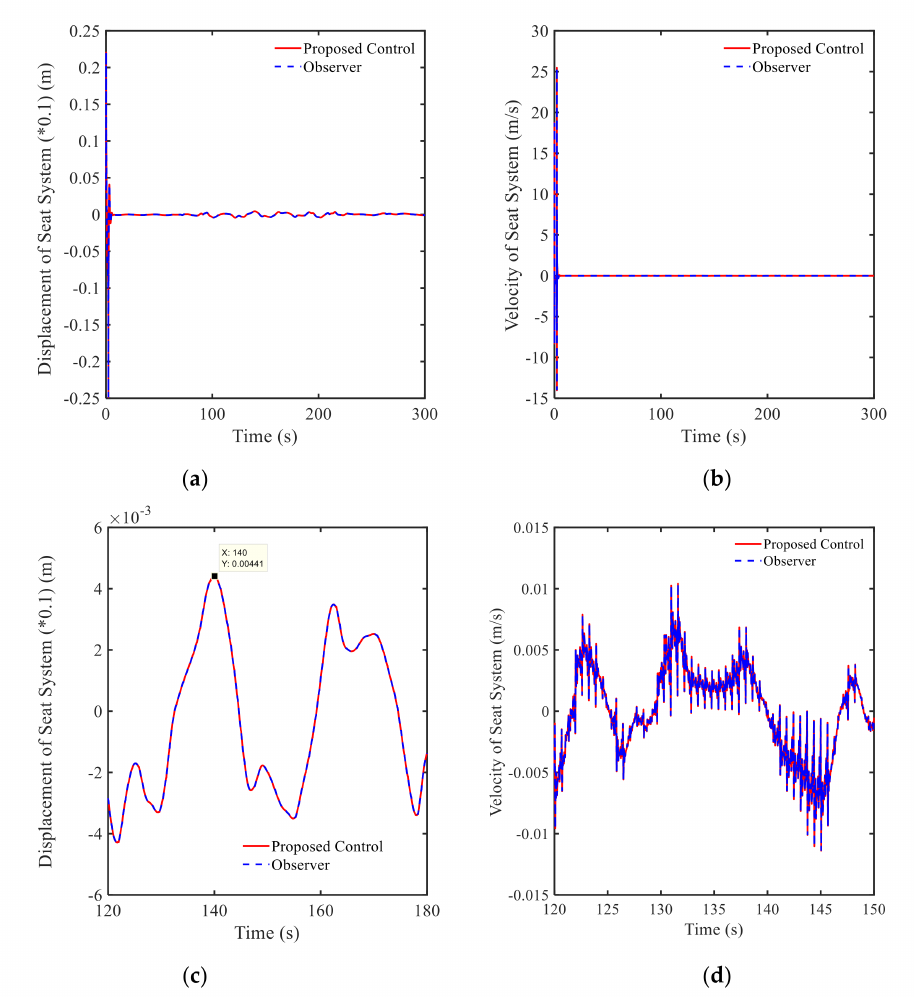
Figure 4. Displacement and velocity of the seat system using the proposed controller: ( a , b ) general view, ( c , d ) enlarged